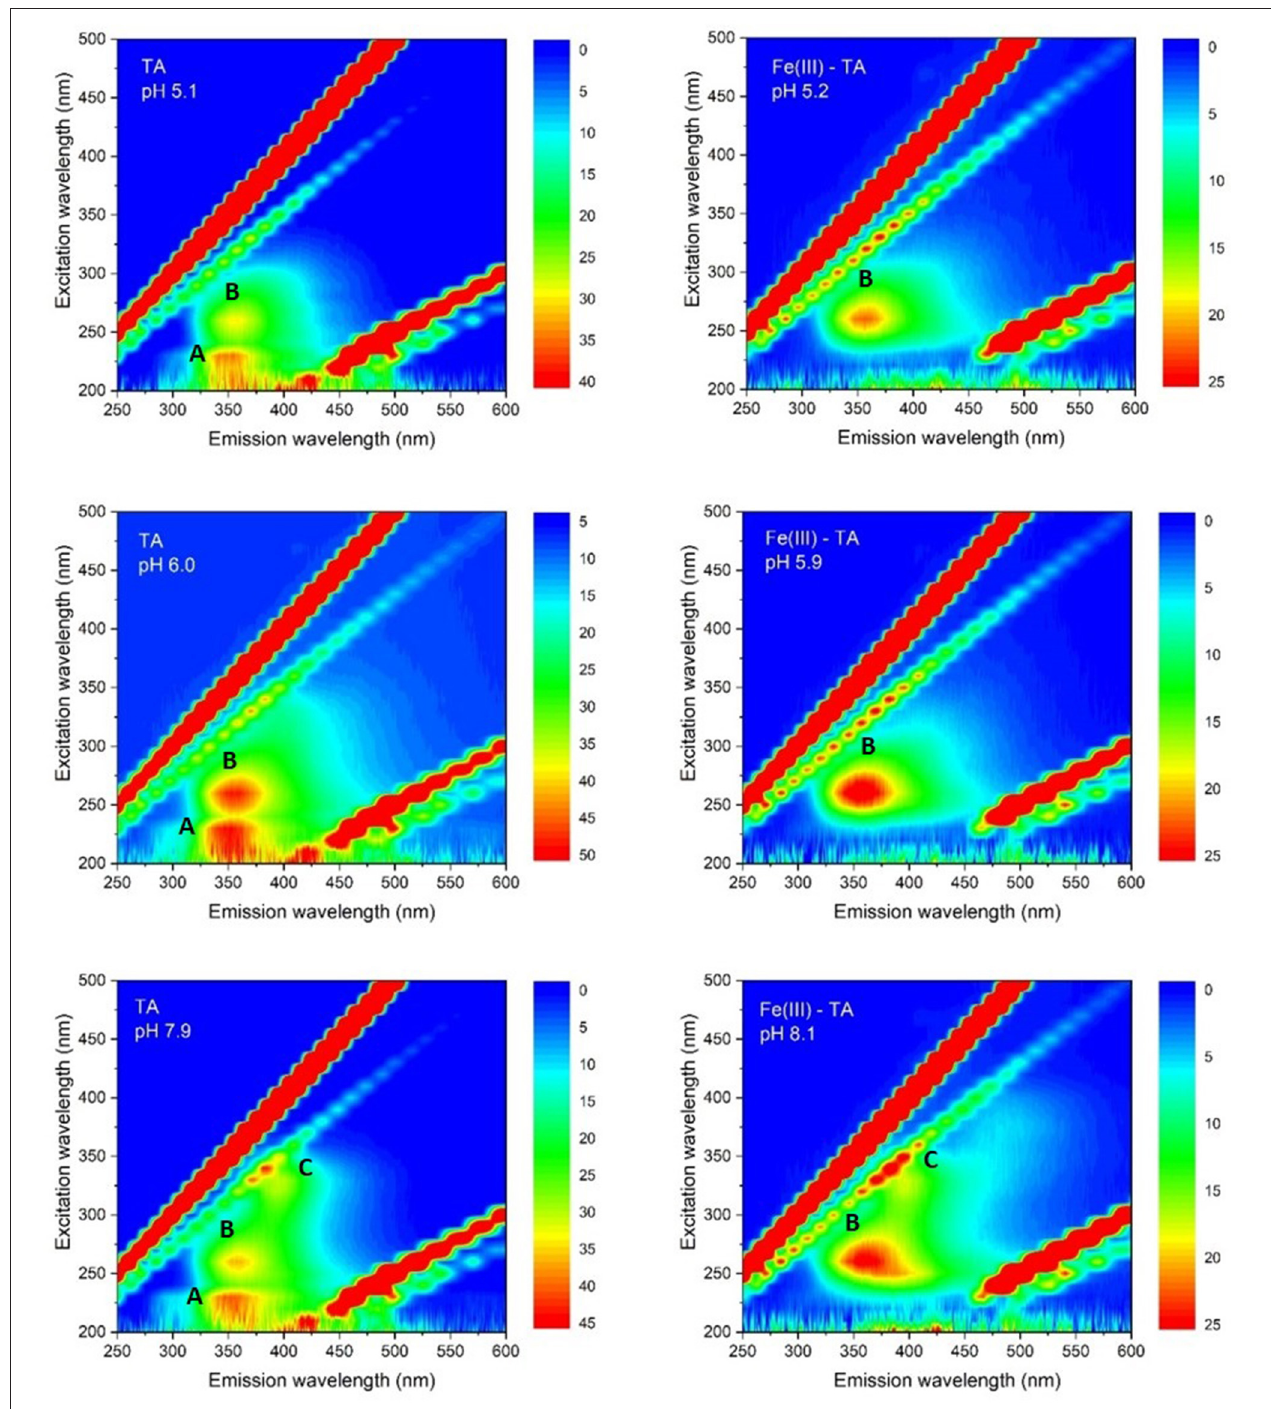
FIGURE 4 | Contour plots of fluorescence EEMs recorded as a function of pH on water solutions of TA 5.0 × 10 − 6 mol L − 1 ; Fe(III)/TA 5.0 × 10 − 6 /5.0 × 10 − 6 mol L − 1 , respectively.